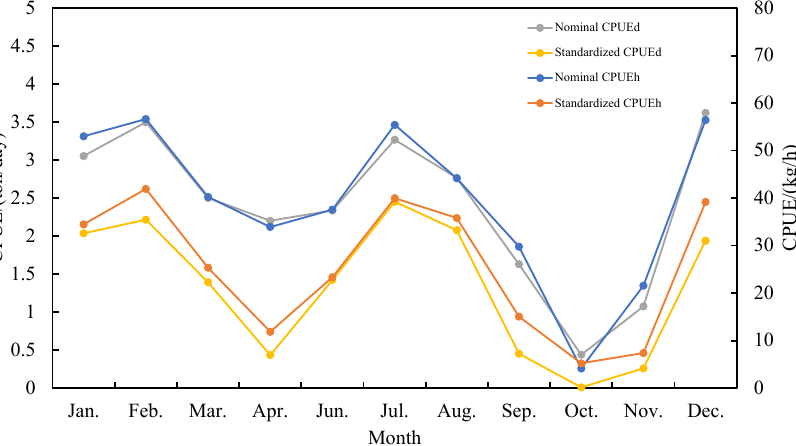
Figure 4. Relationship between monthly nominal CPUE and GAM standardized CPUE of the Chinese squid-jigging fishery in the equatorial waters of Eastern Pacific.